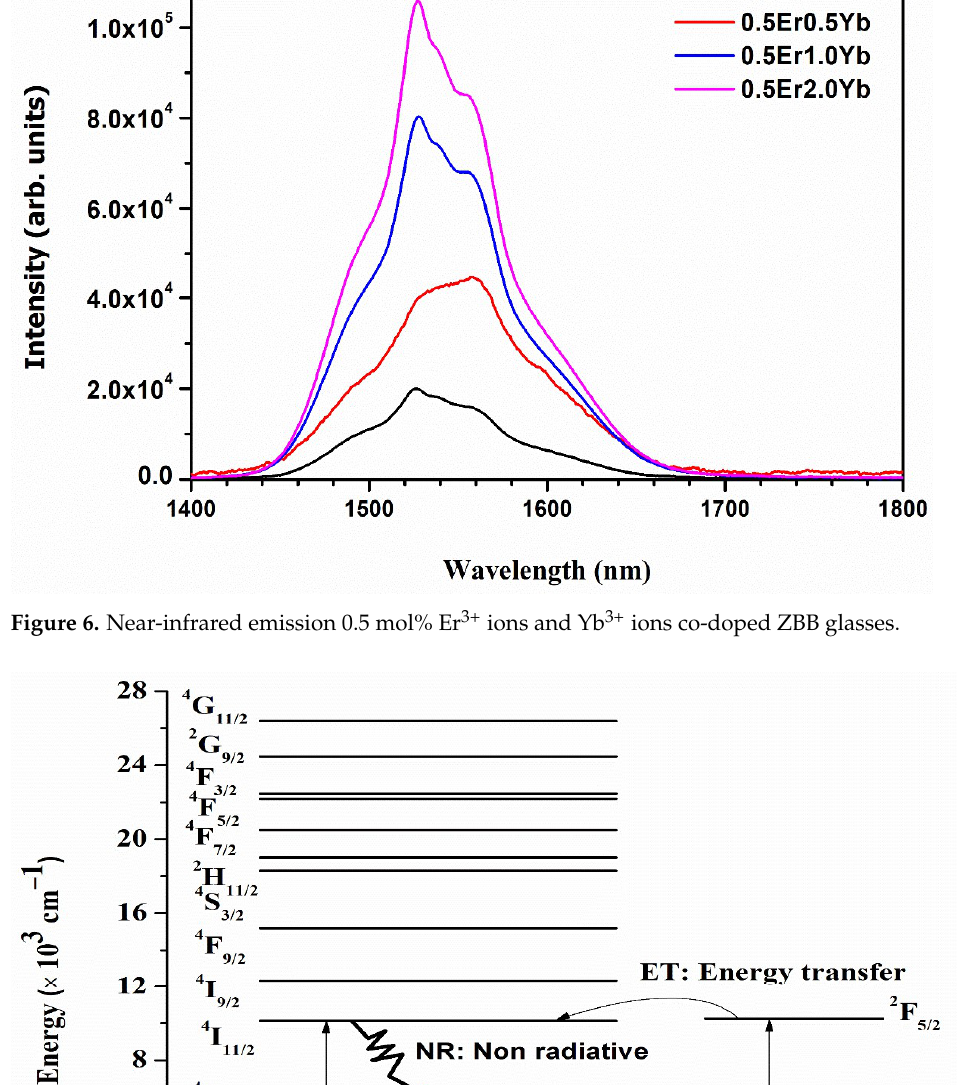
Photonics 2022 , 9 , x FOR PEER REVIEW